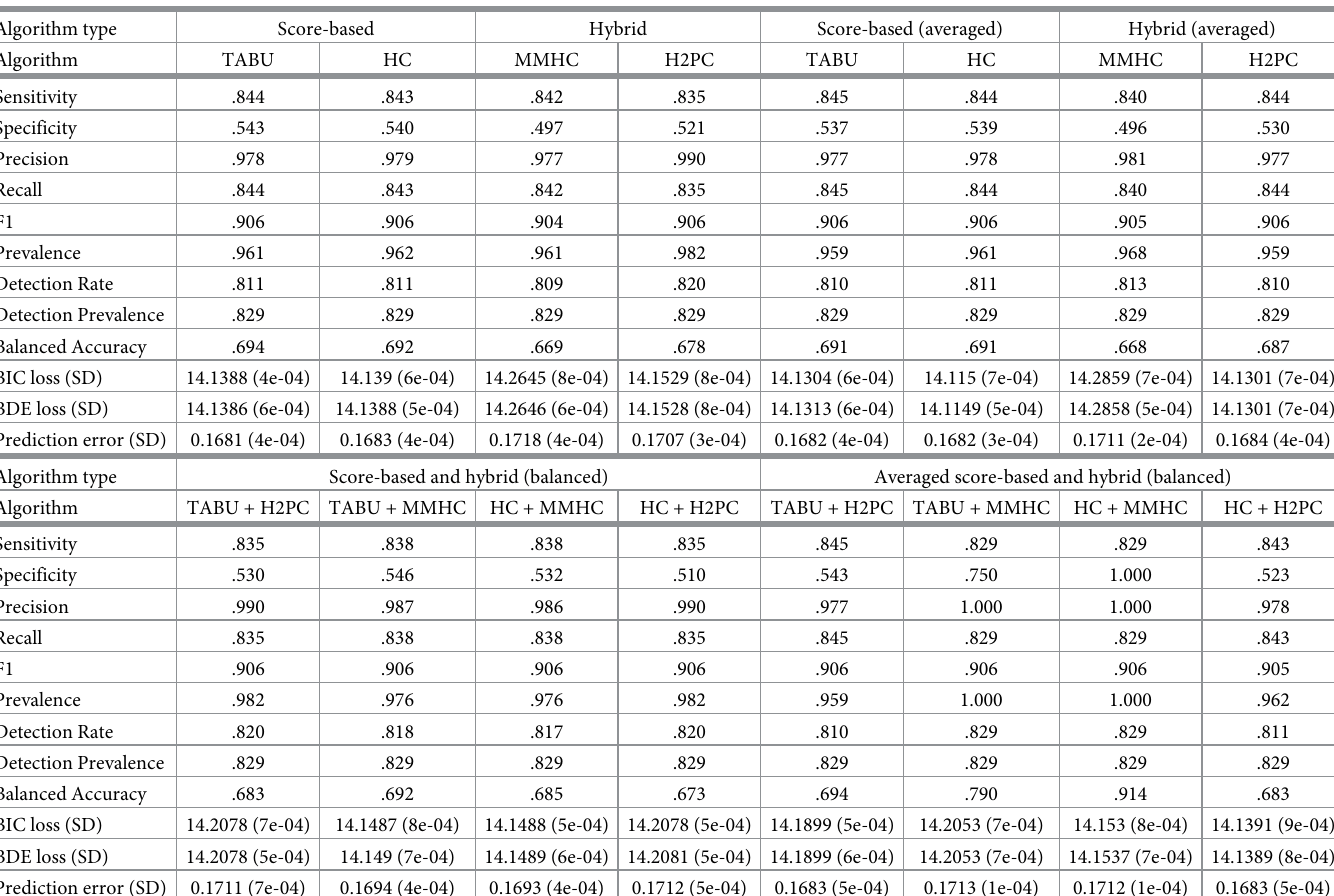
Table 3. The results of cross-validation using different BN